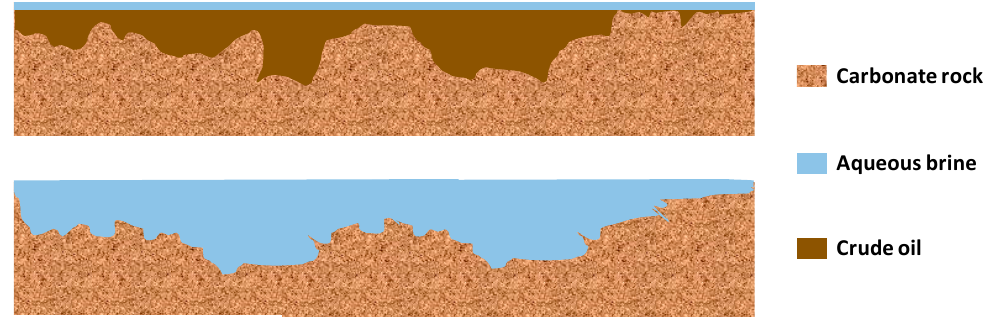
Figure 12. An illustration of the proposed mechanism of wettability alteration by “dissolution” showing an oil-wetting state with oil attachment before dissolution ( top ) and the water-wetting state after dissolution ( bottom ) (adapted from Hiorth et al. [65]).